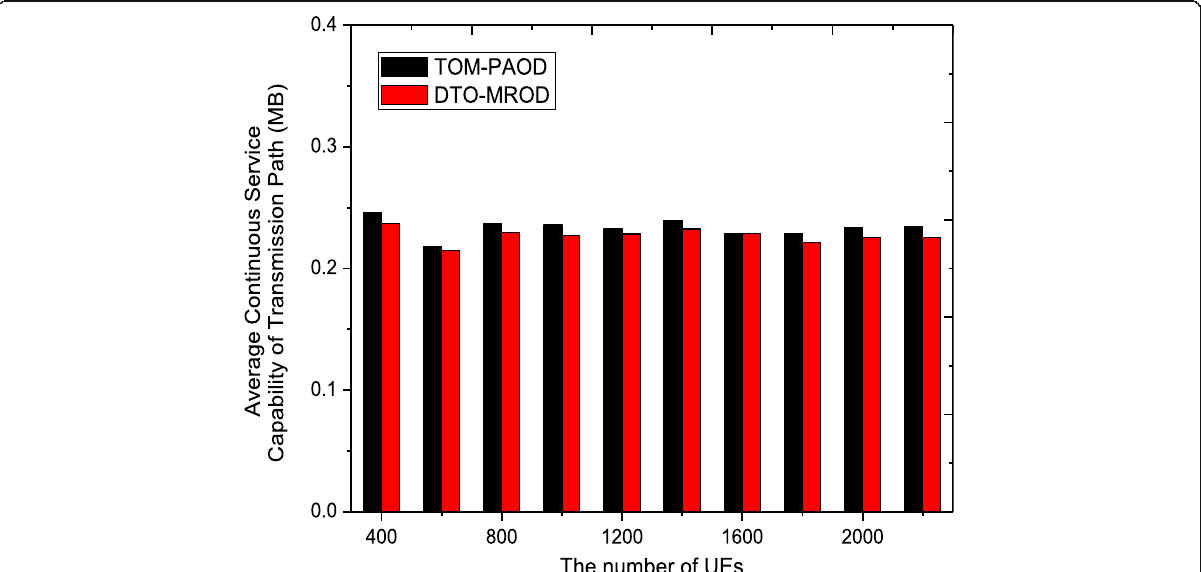
Fig. 5 Comparison of continuous service capacity: variation trend of continuous service capacity in the two schemes with the number of UEs in the given region